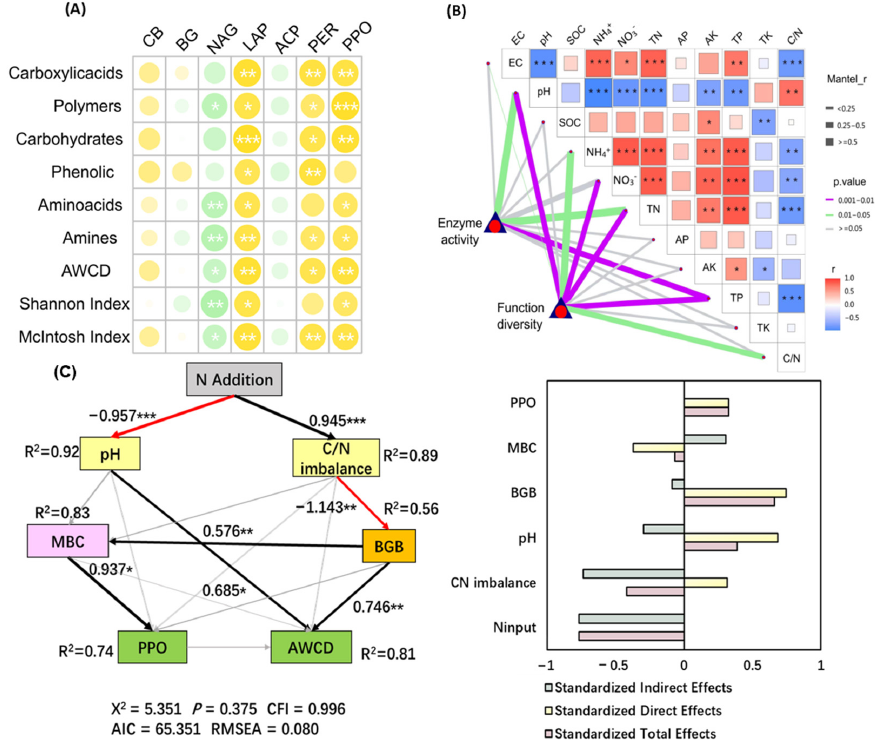
Figure 5. ( A ) Relationships between the enzyme-related parameters and the CLPP-related parameters. ( B ) Pearson correlations among edaphic and environmental factors. Microbial function and enzyme activities were linked to each factor by Mantel tests. Links width is proportional to Mantel’ r, and link color signifies the level of significance. ( C ) The structural equation model (SEM) shows the potential causal relationships among soil-plant properties and microbial parameters. Data on the soil CN imbalance are the PC1 and PC2 results from the principal component analysis (PCA) of soil C (N) (including soil TOC, TN, C/N, NH 4+ , NO 3 − ). Black and red arrows represent significant positive and negative pathways, respectively. Arrow width corresponds to the path coefficient (numbers on the arrows). R 2 near the observed parameters denotes the proportion of the variance explained by other variables in the model. *** p < 0.001, ** p < 0.01, * p < 0.05.